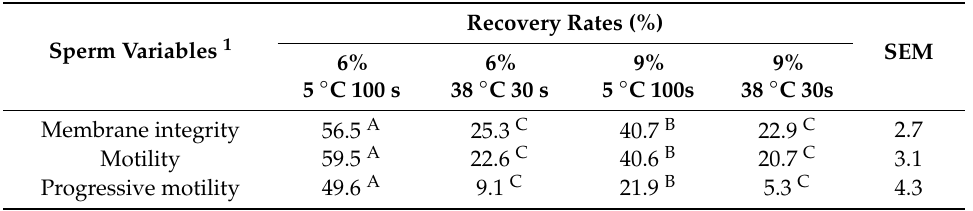
Table 3. Recovery (LSMeans ± SEM) of undamaged membrane, motile and progressively motile sperm after cryopreservation with di ff erent N-Methylacetamide concentration-thawing rate combinations. Recovery Rates Sperm Variables 1